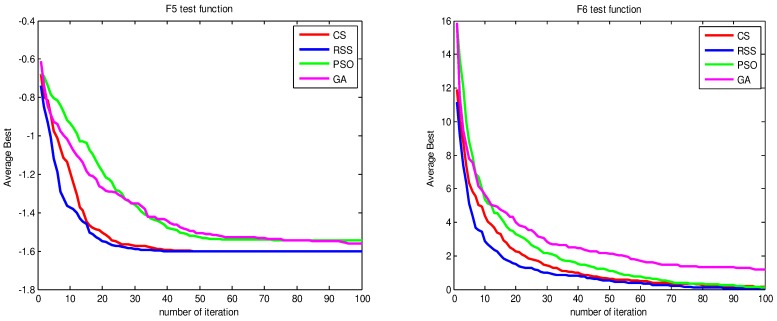
AB convergence of CS, RSS, PSO and GA for minimization of (a) F5 and (b) F6.